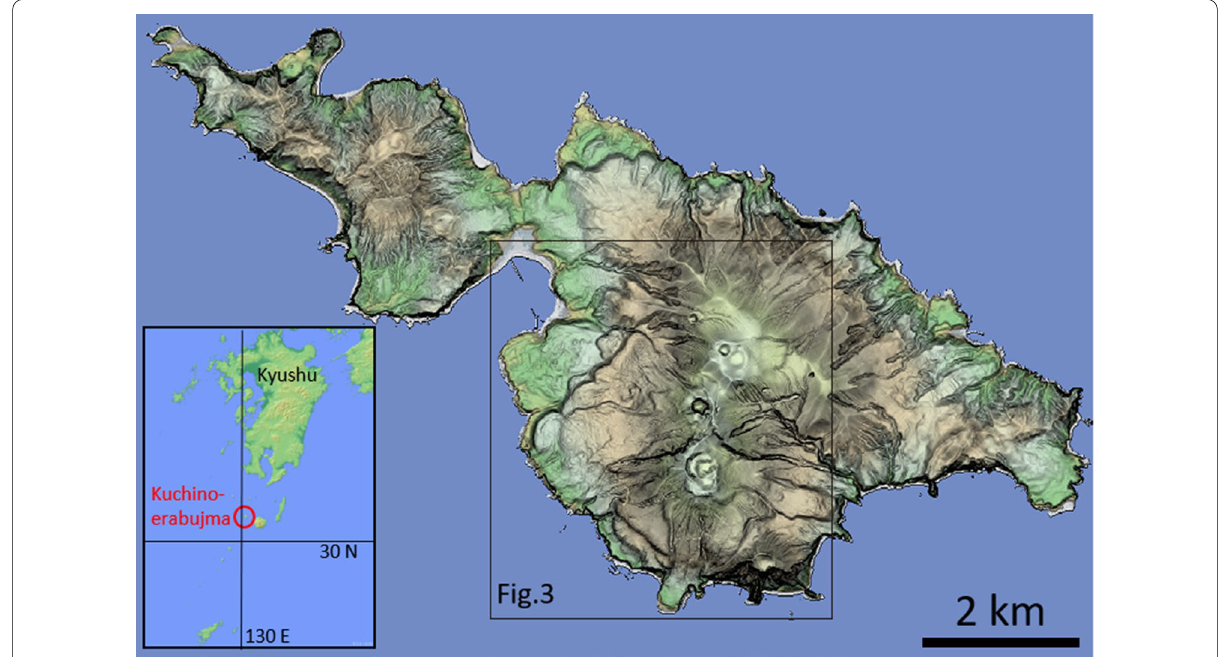
Fig.1 Topographic map of the Kuchinoerabujima Island. The relief map was created using the 10-m-mesh digital elevation model provided by Geospatial Information Authority of